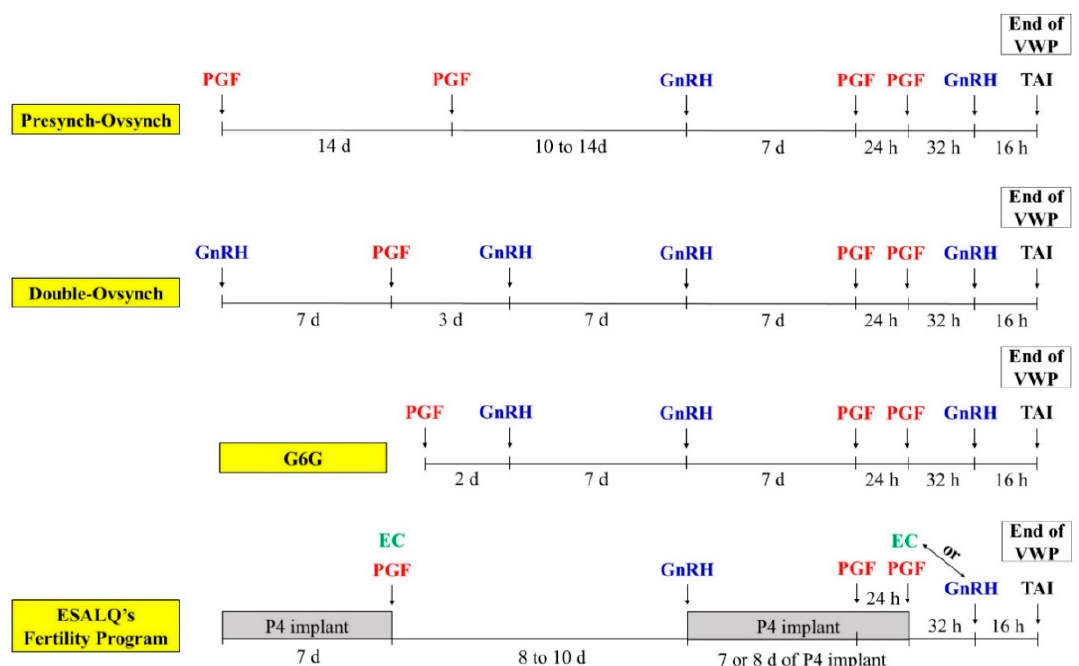
Figure 4. Hormonal treatments used in four fertility programs that are discussed in the text. These programs can be used to achieve 100% service rate and improved pregnancy per artificial insemination compared to the first postpartum timed artificial insemination (TAI) in lactating dairy cows. Voluntary waiting period (VWP), gonadotropin-releasing hormone (GnRH), prostaglandin F2 α (PGF), progesterone (P4), and estradiol cypionate (EC).